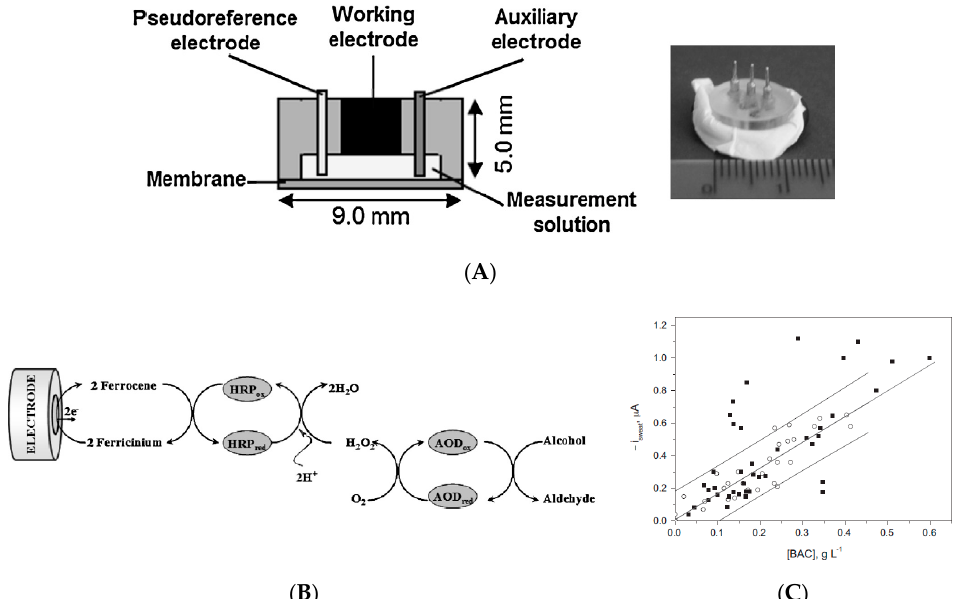
Figure 29 . ( A ) Scheme of the various parts of the device (right: picture with contact electrodes). ( B ) Overall reactions involved in the sensing mechanism, which involves alcohol oxidase (AOD), a second enzyme (horse radish peroxidase—HRP) and ferrocene as mediator. ( C ) Correlation between the device output signal and blood alcohol concentration (BAC) values: ( ■ ) values measured with the biodevice in the single measurement mode, ( ○ ) values measured with the biodevice in the single measurement mode at 5 minutes (in both cases: n = 40 subjects). The straight lines show the corresponding BAC intervals obtained by the gas chromatography method. Reproduced from [91] with permission. Copyright © 2013 Elsevier B.V. All rights reserved.